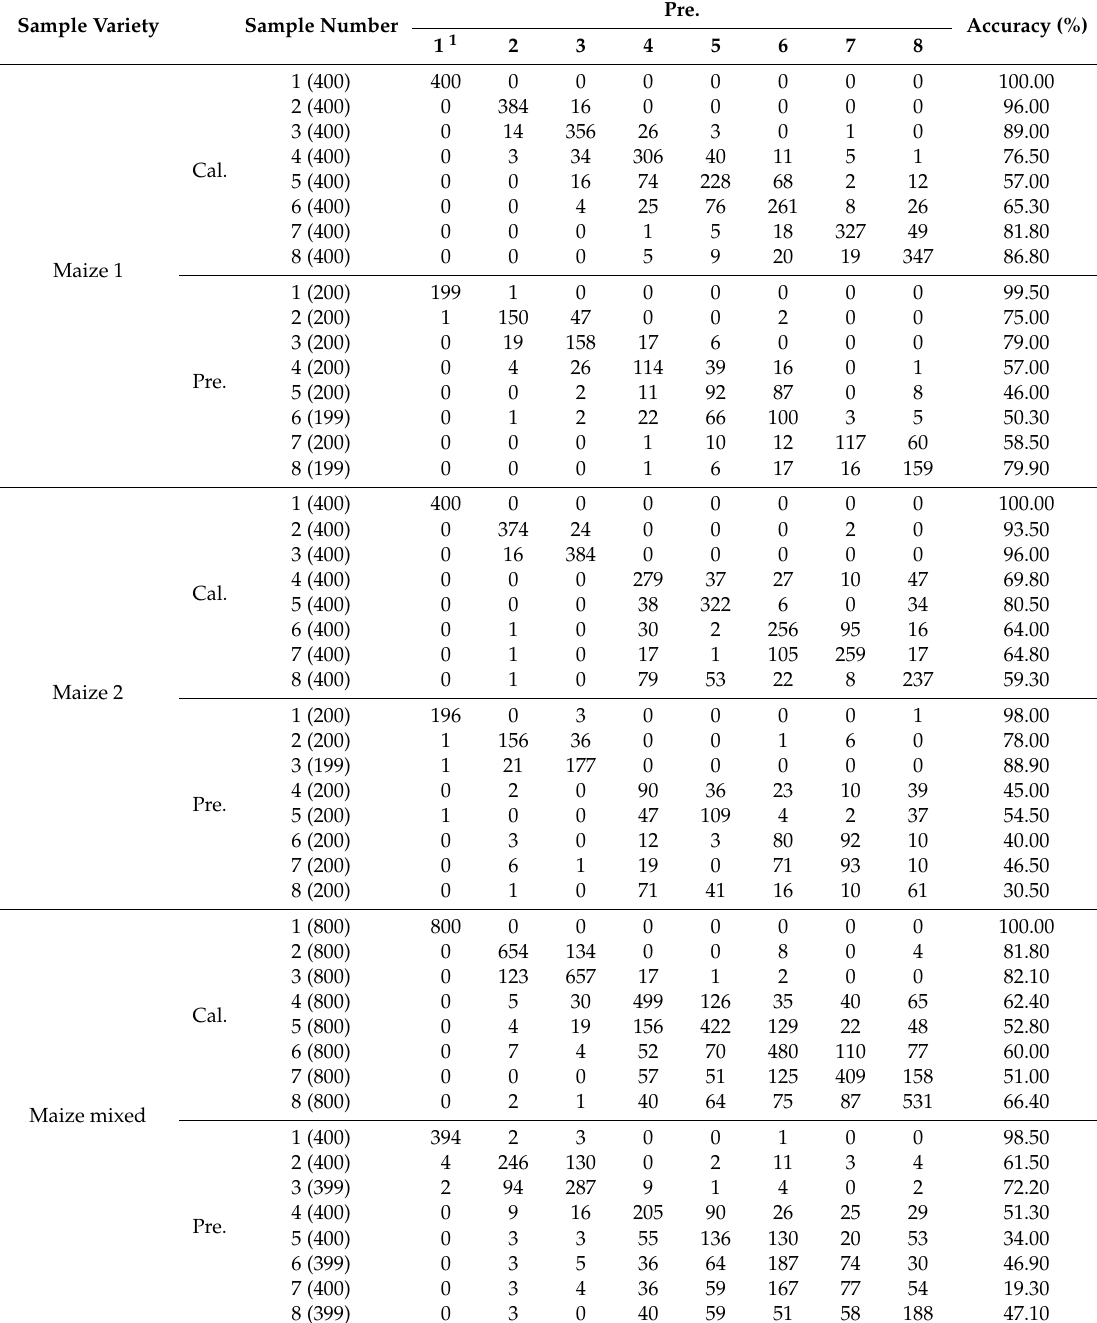
Table 2. Confusion matrix of SVM models using full